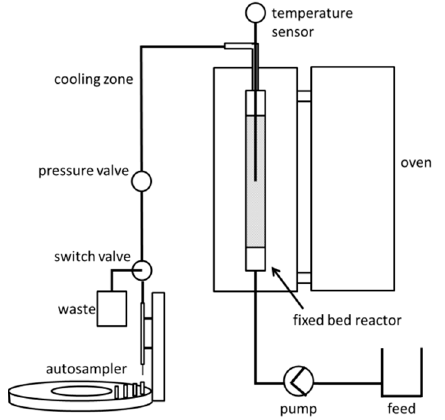
Figure 6. Fixed bed reactor setup.